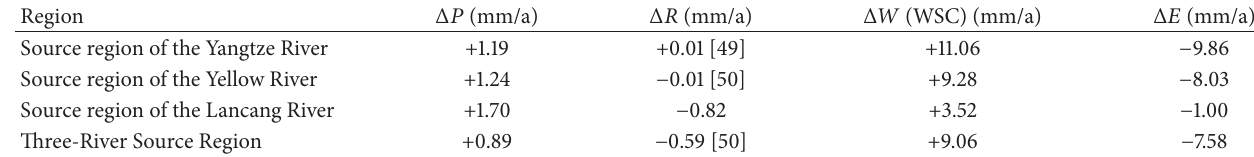
Table 5: Average rates of water thickness change in the subregions of the Three-River Source Region. Region